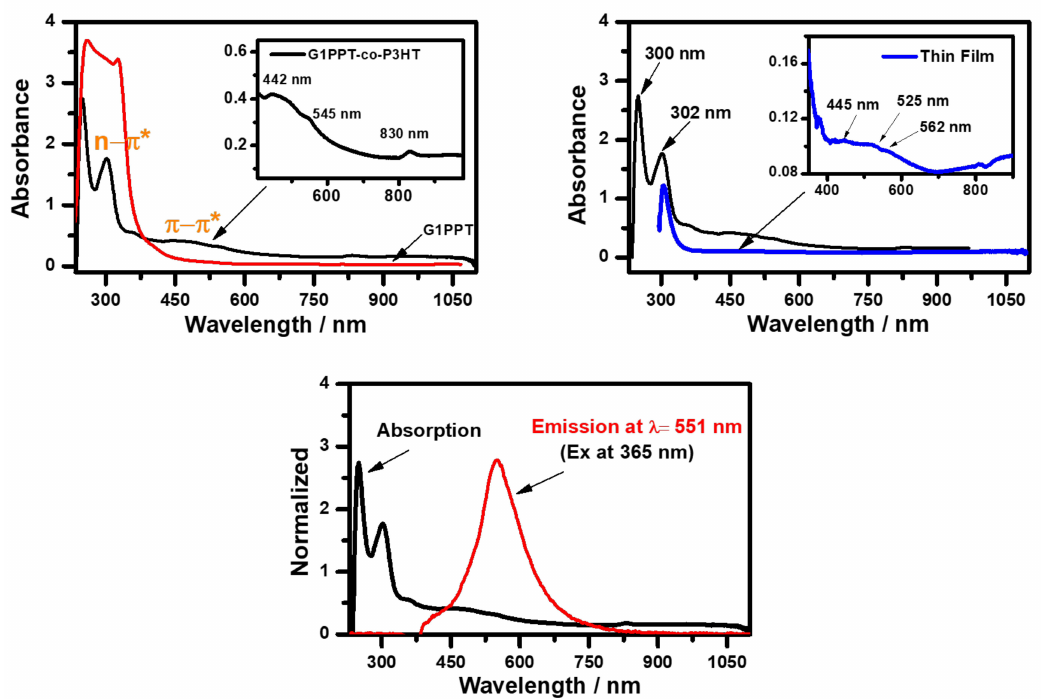
Figure 4. UV-Vis absorption spectra of G1PPT-co-P3HT and G1PPT in chloroform solution ( top left ), as thin film ( top right ) and photoluminescence spectrum ( bottom )